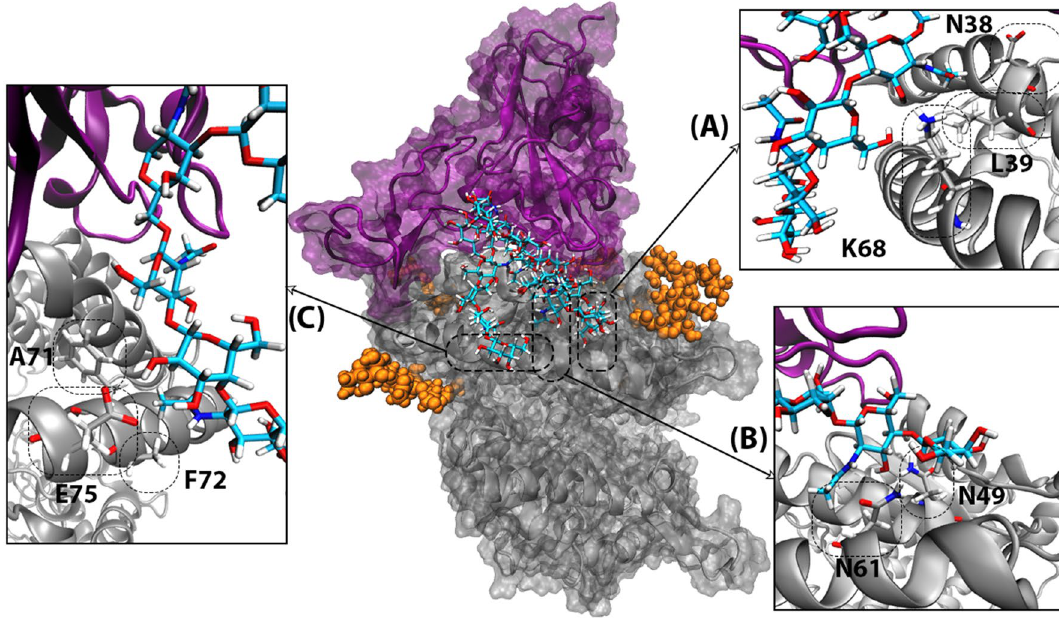
Figure 8. The extracellular domain of human ACE2 and RBD of the SARS-CoV-2 S protein are shown with gray and purple respectively. The RBD attached O-glycan is shown with atom name sticks. N-glycans in the proximity of RBD-ACE2 interface are shown with orange spheres. Persistent polar interactions between H1 and H2 of ACE2 and the attached O-glycan are shown in